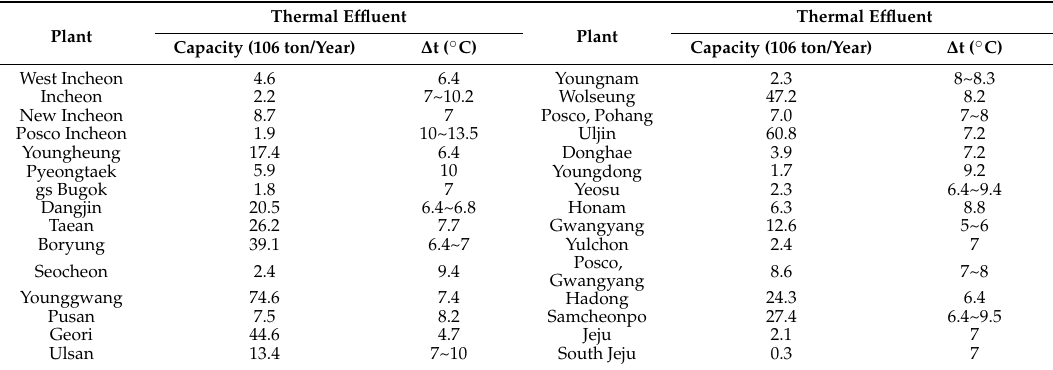
Table 1. Emission situation of power plant thermal effluent